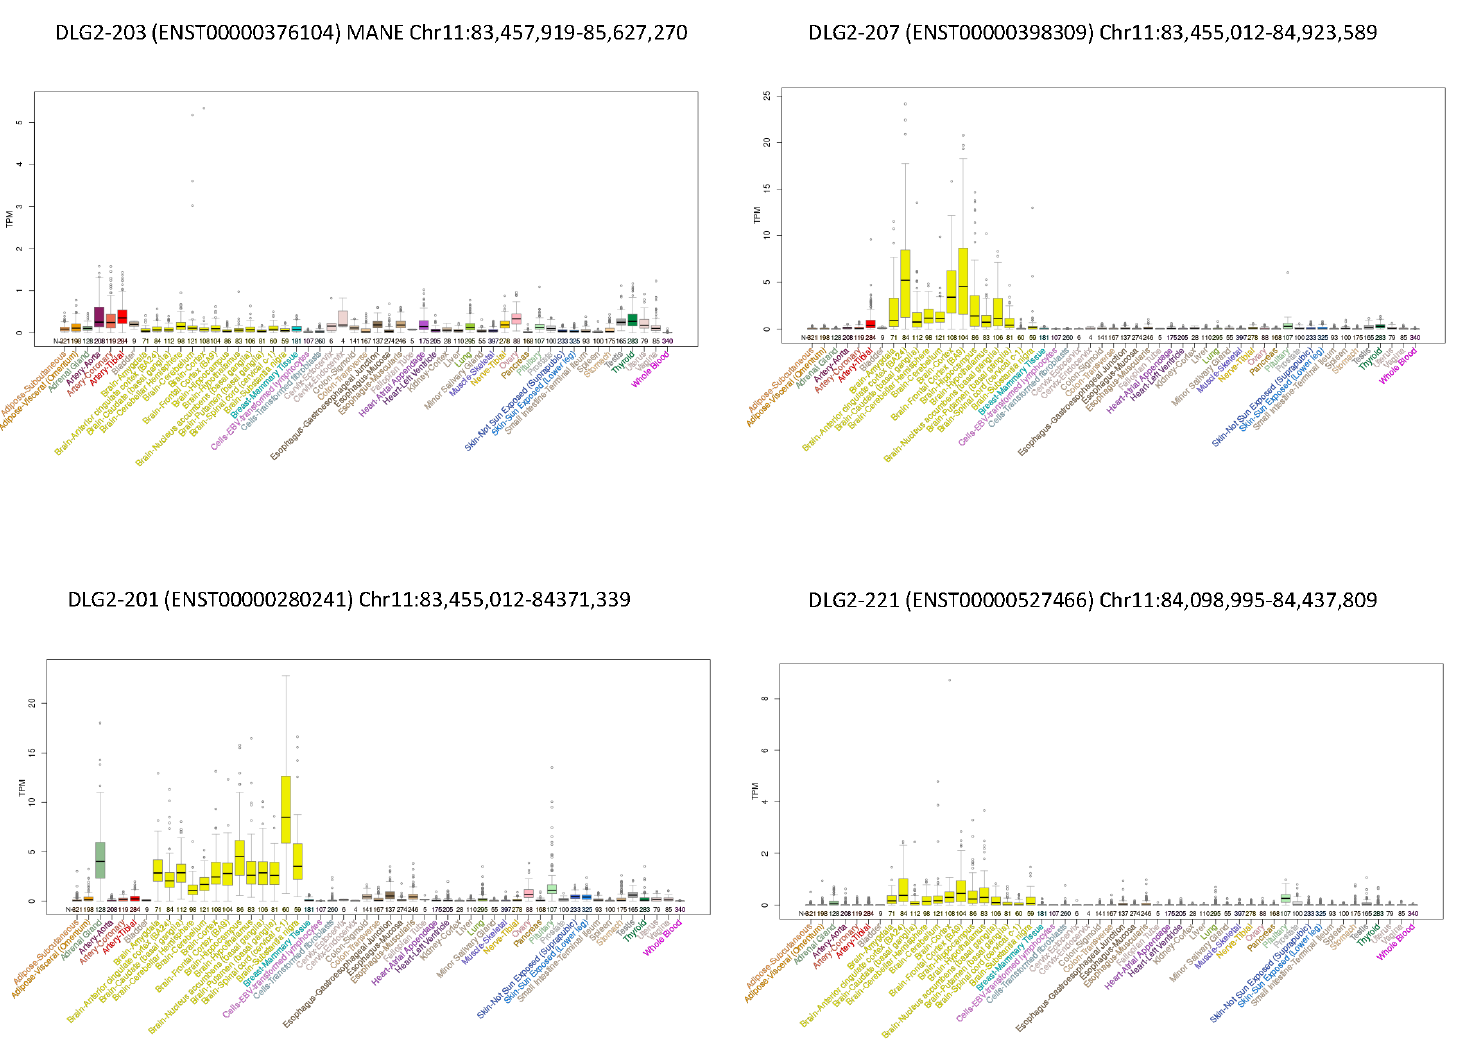
Figure 2. Expression of some DLG2 transcripts across tissues from the GTEx Project. Examples of expression profiles: DLG2-203 (MANE) was ubiquitous; DLG2-207, DLG2-201, and DLG2-221 were prevalently expressed in CNS, with different patterns in brain